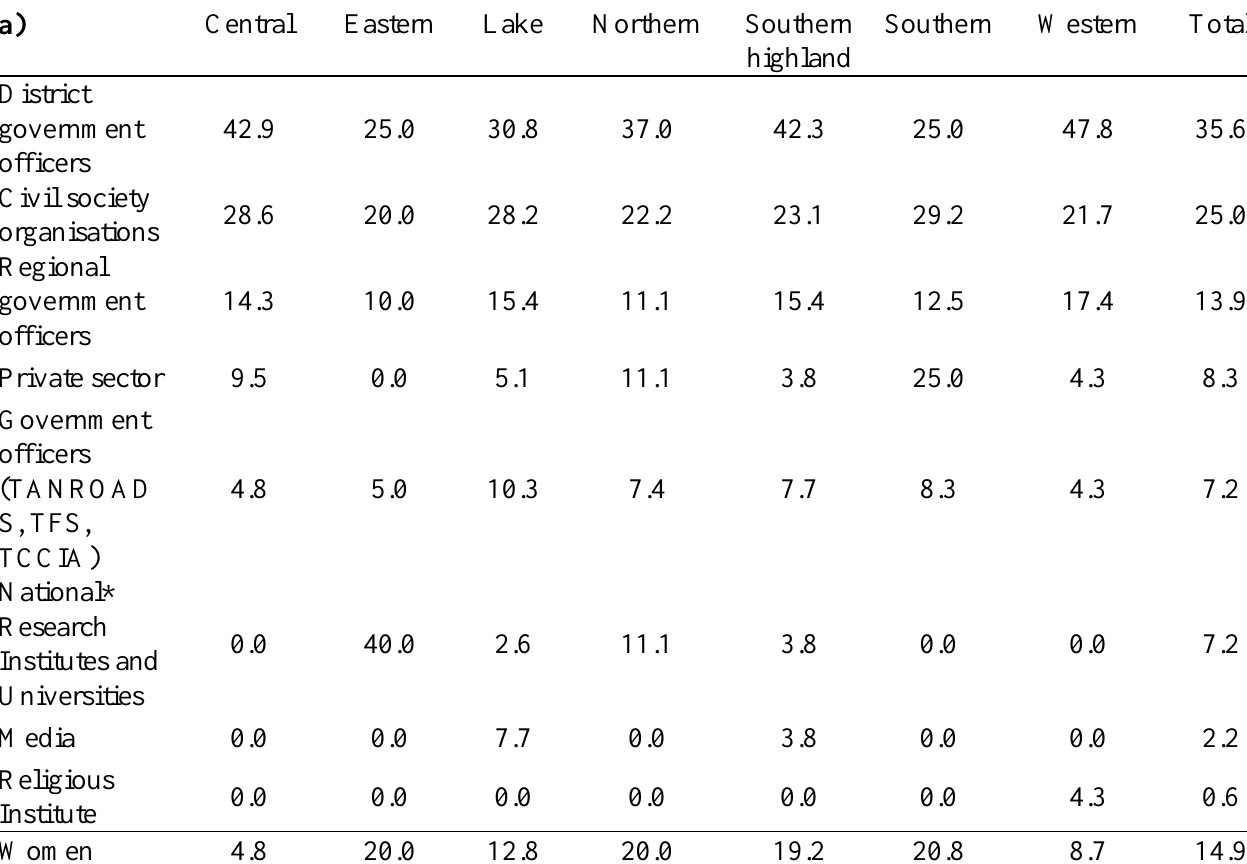
Table A1.1: Stakeholders’ composition in regional a) and national b) workshops in Tanzania. Frequency (%) of participants is reported by institution categories and gender (women) by regions. Women were more represented in research institutions and civil society organisations (38.5 and 32.5 %, respectively) than in governmental institutions